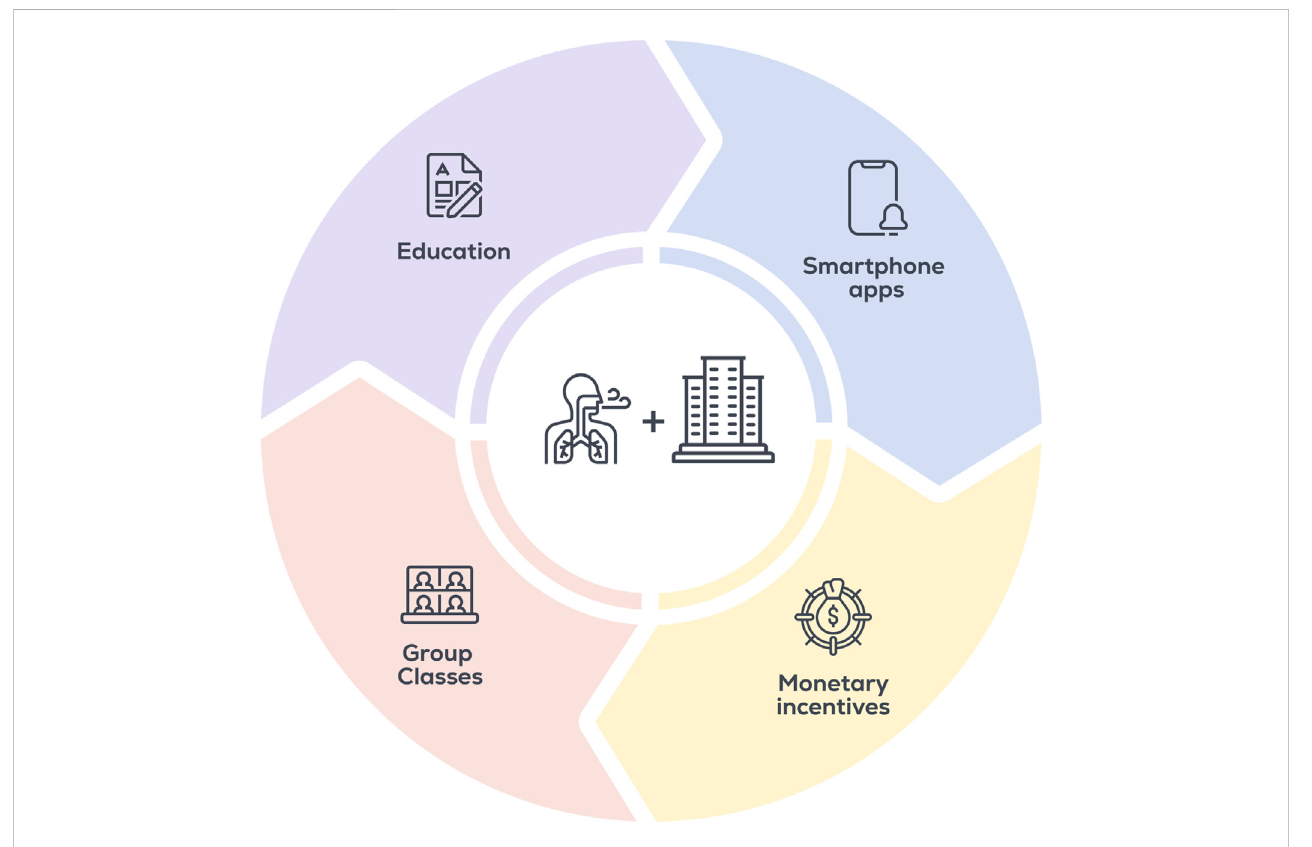
FIGURE 2 Strategies to implement DBE and increase adherence in the